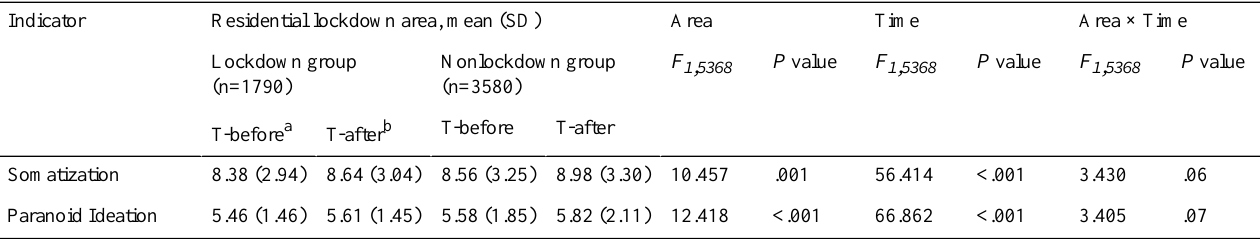
Table 5. Repeated measures analysis of variance on subjective well-being across